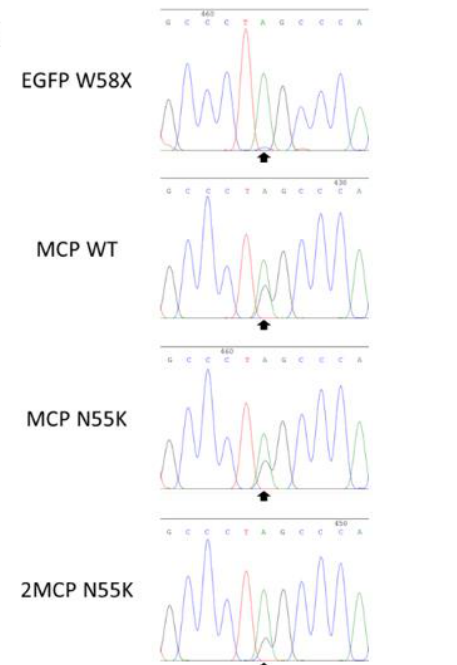
Figure 2. ( a ) Waveform data around the target site from Sanger sequencing. Black arrows indicate the target base for EGFP W58X. ( b ) Bar graph showing the editing efficiency (%) calculated from the sequencing results using the peak height ratio method. Error bars represent standard error ( n = 3). Asterisks indicate statistically significant difference ( p < 0.05). NS (not significant) signifies no statistically significant difference.